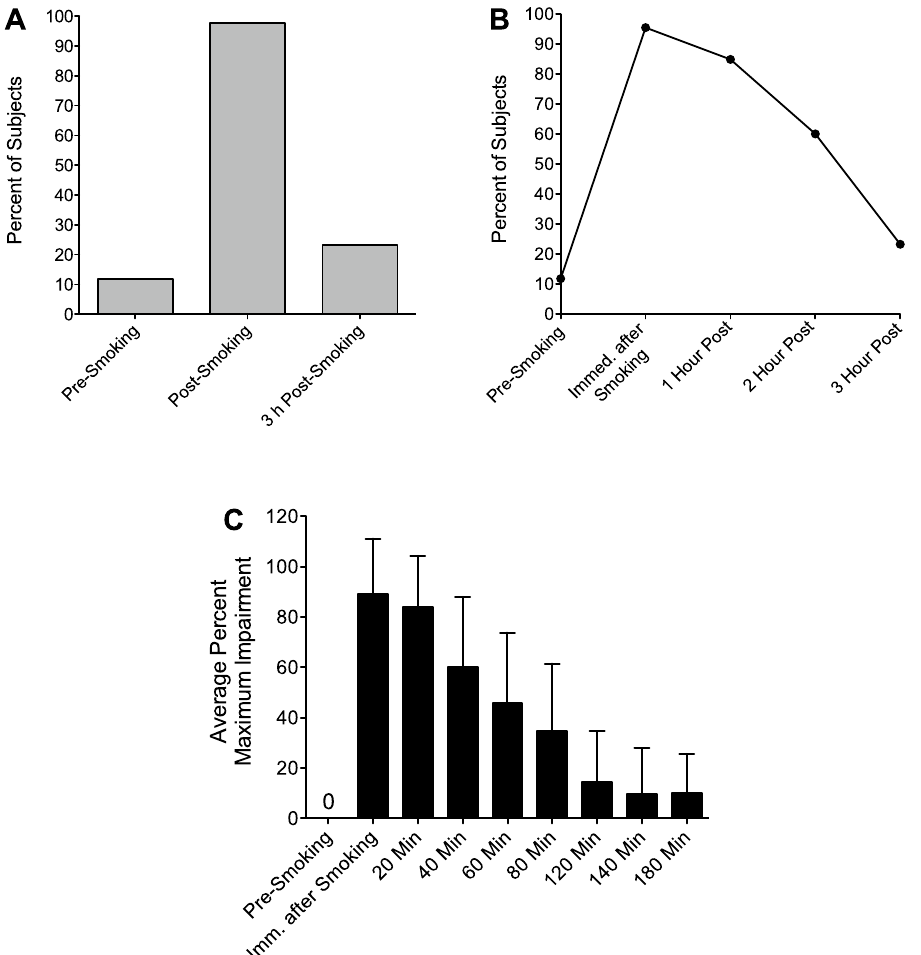
Figure 2. Pre- and post-smoking incidence of horizontal gaze nystagmus and correlation with impairment. ( A ) Overall incidence of nystagmus within the three-hour impairment window ( N = 34 pre-smoking; N = 44 post- smoking; N = 43 3 h post-smoking); ( B ) incidence of nystagmus within the three-hour impairment window over time ( N = 34 pre-smoking; N = 44 immediately after smoking; N = 33 1 h post-smoking; N = 10 2 h post-smoking; N = 43 3 h post-smoking); ( C ) average percent maximum impairment (+ SD) pre-smoking to three hours post- smoking ( N = 74).